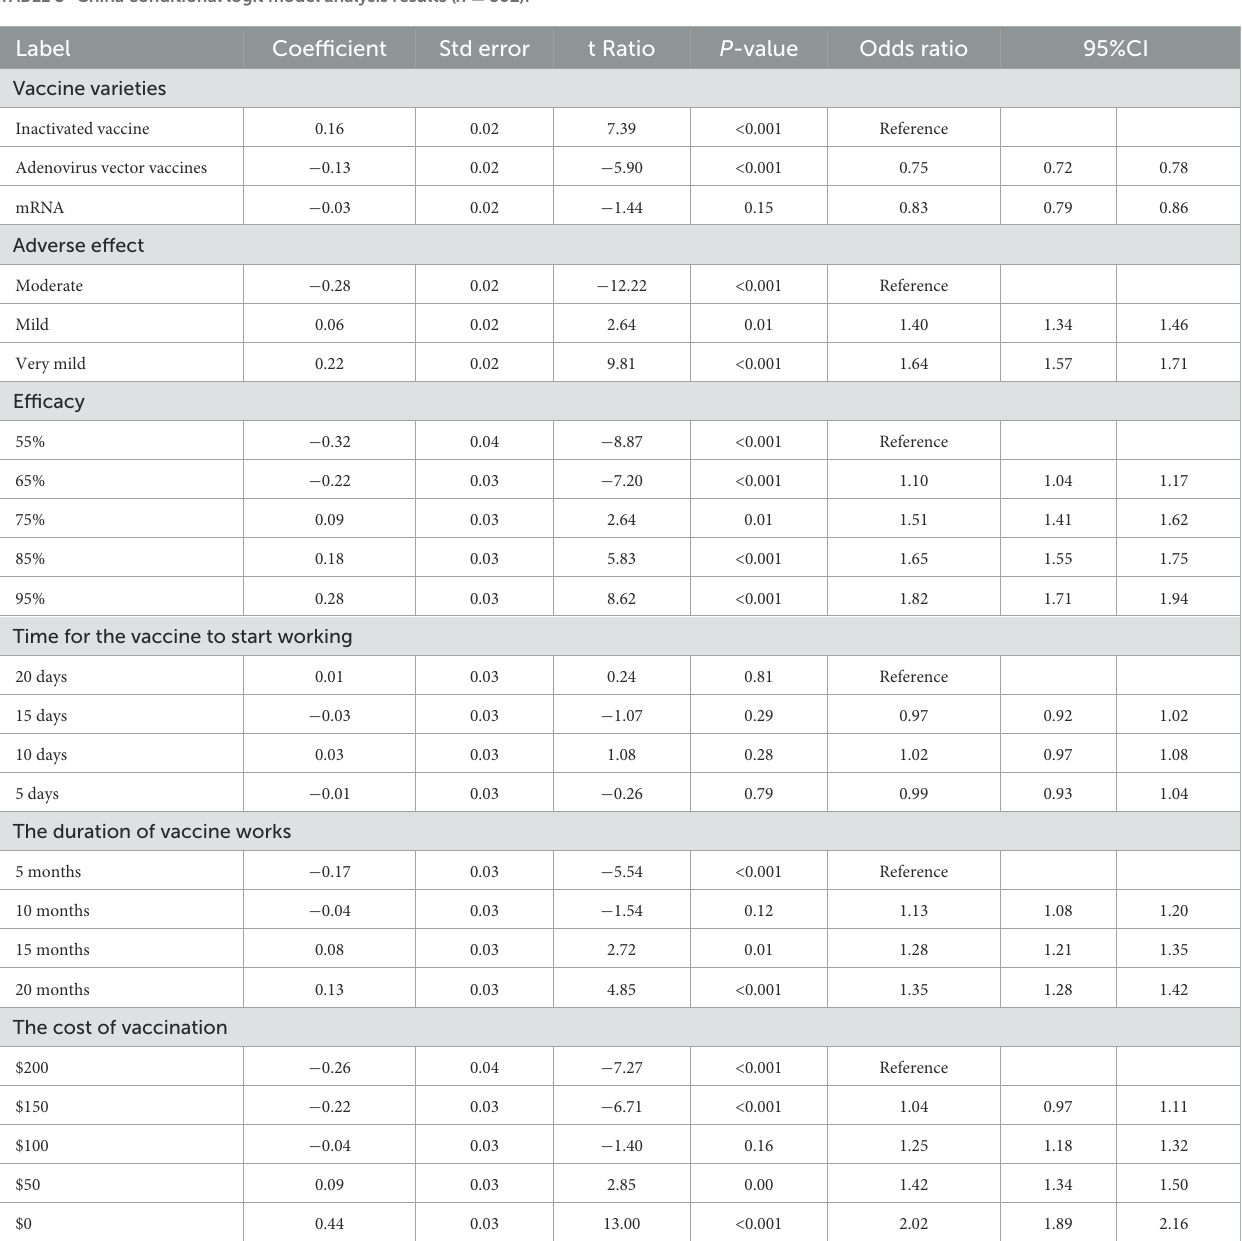
TABLE 5 China conditional logit model analysis results ( n =